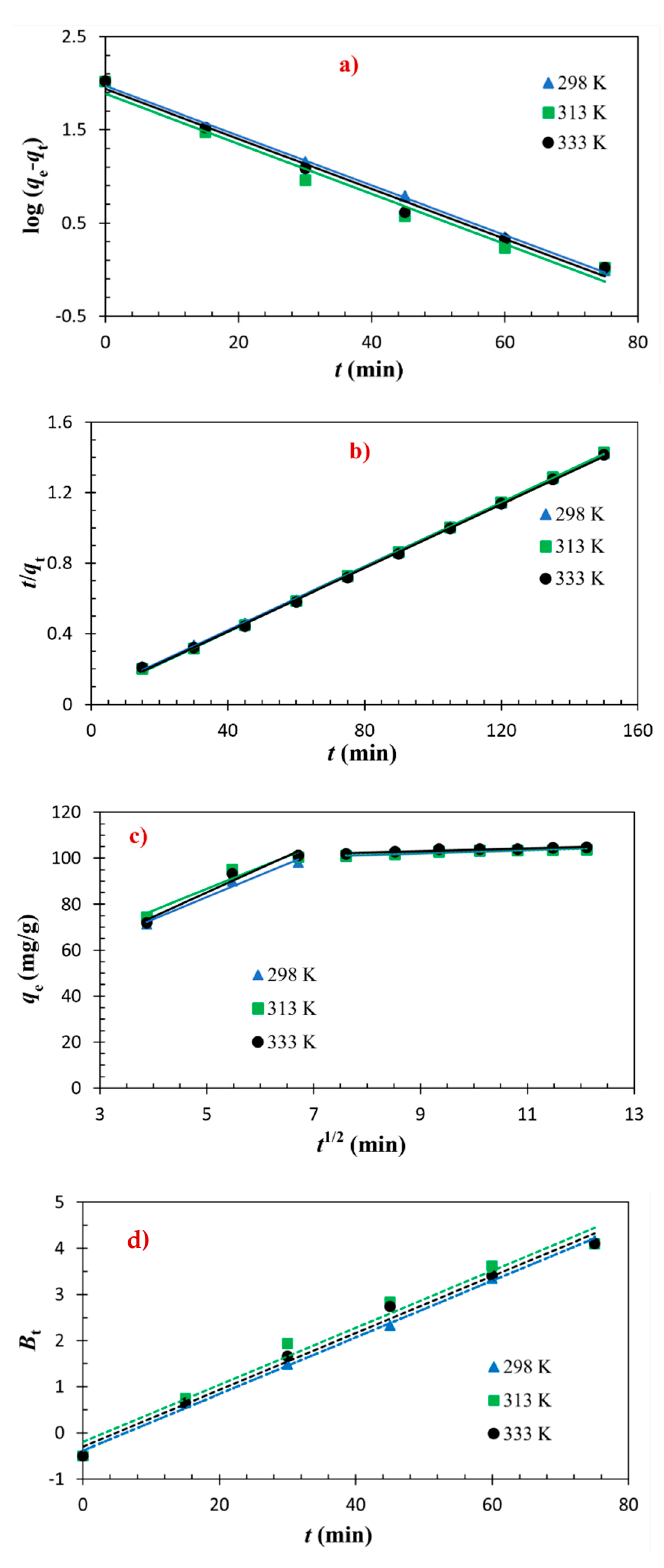
Figure 12. Adsorption kinetics of adsorption of MB by rGO for ( a ) pseudo – first order, ( b ) pseudo – second order, ( c ) intraparticle diffusion (IPD), and ( d ) Boyd kinetic models (conditions: C MB0 = 20 mg/L, V = 100 mL; W rGO = 15 mg). Table 1. Parameters obtained from different kinetics models for MB adsorption on rGO a . Models and Equations